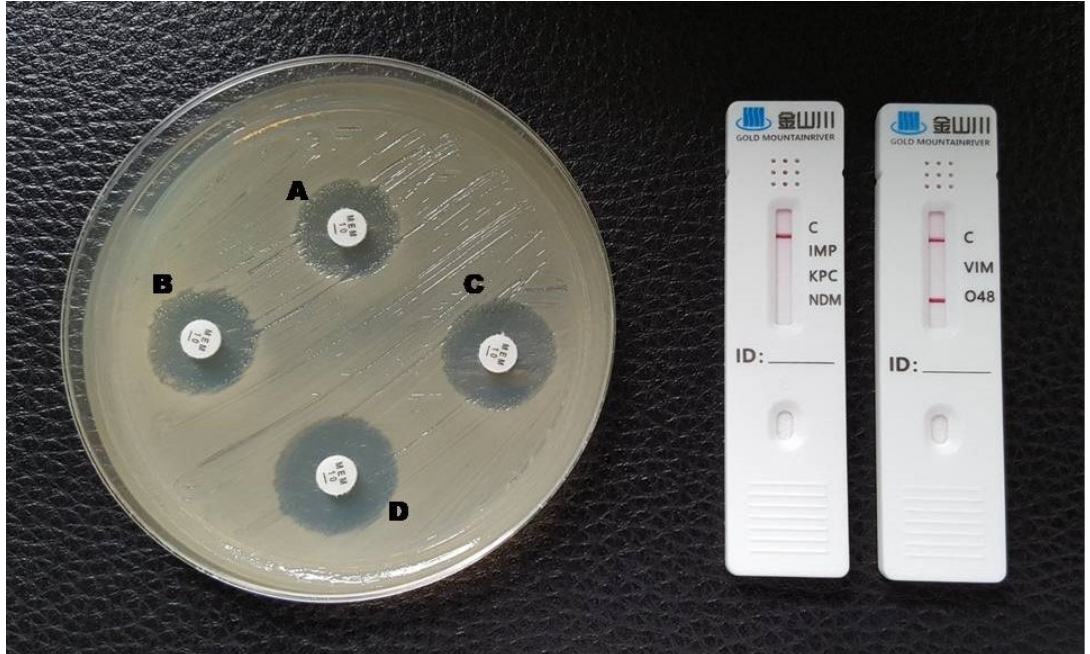
Figure 4. Phenotypic and lateral flow assay results for an OXA ‐ 48 ‐ producing K. pneumoniae . A: meropenem disc without inhibitors; B: meropenem + EDTA; C: meropenem + phenylboronic acid; D: meropenem + EDTA + phenylboronic acid. The test could not be interpreted by the double